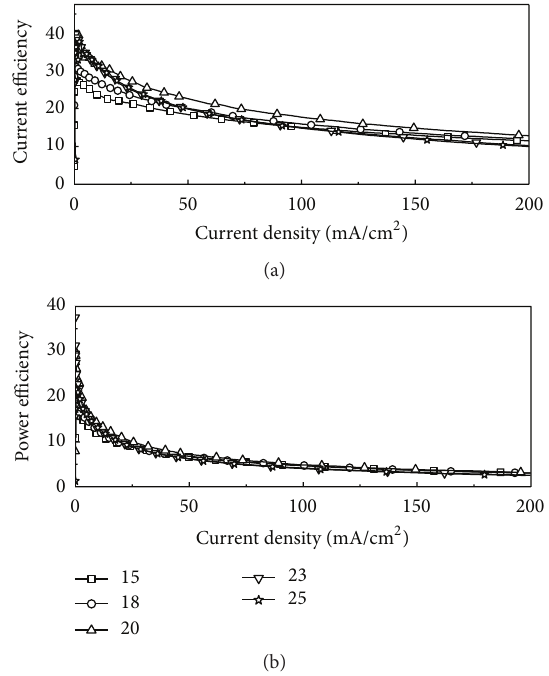
Figure 6: Current efficiency-current density characteristics of devices B1, B2, B3, B4, and B5 (a) and power efficiency-current density characteristics of the devices